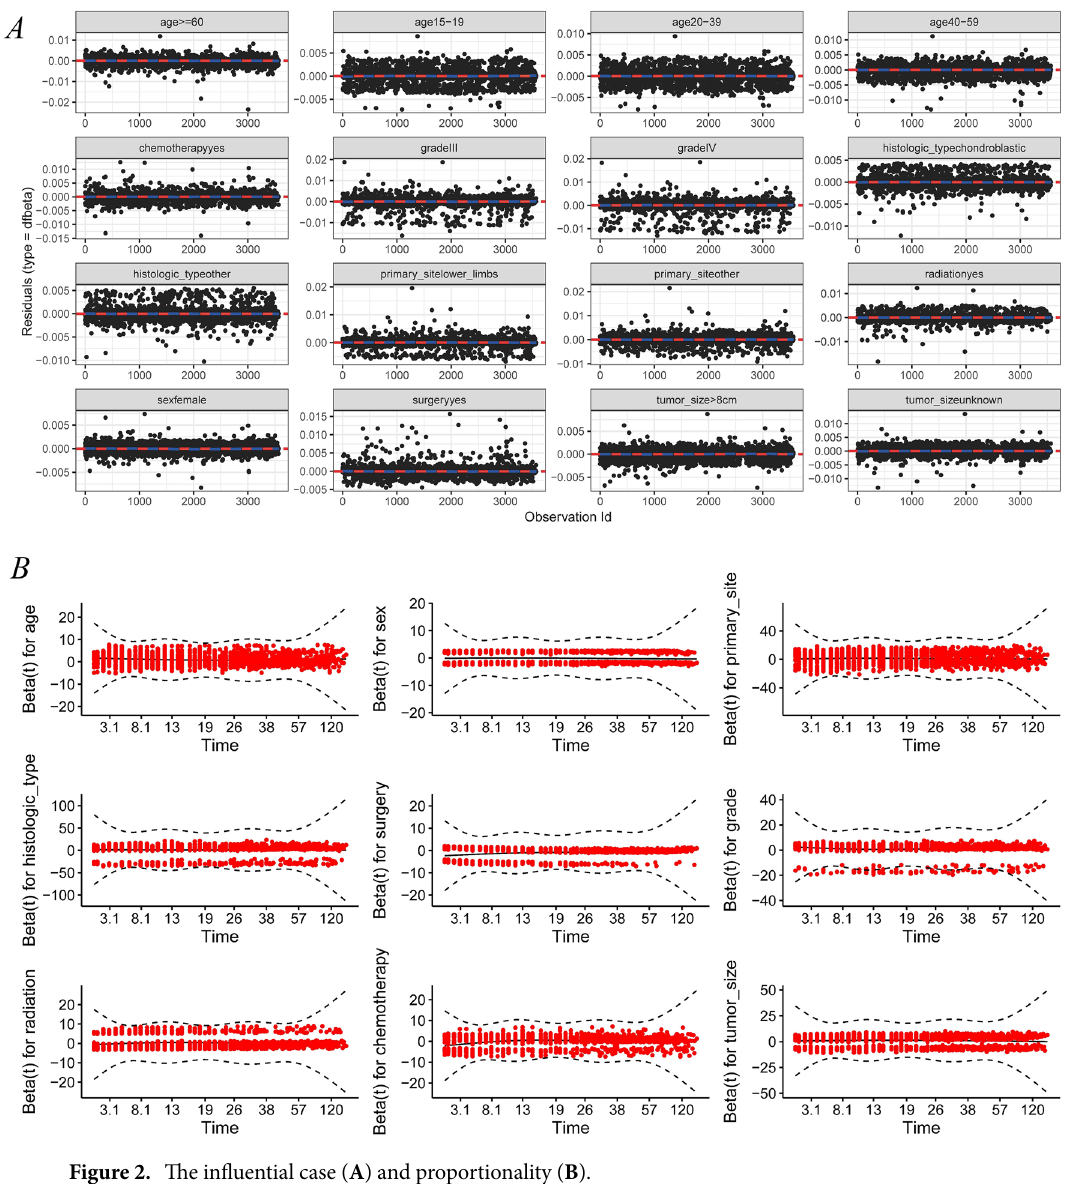
Figure 2. The influential case ( A ) and proportionality ( B